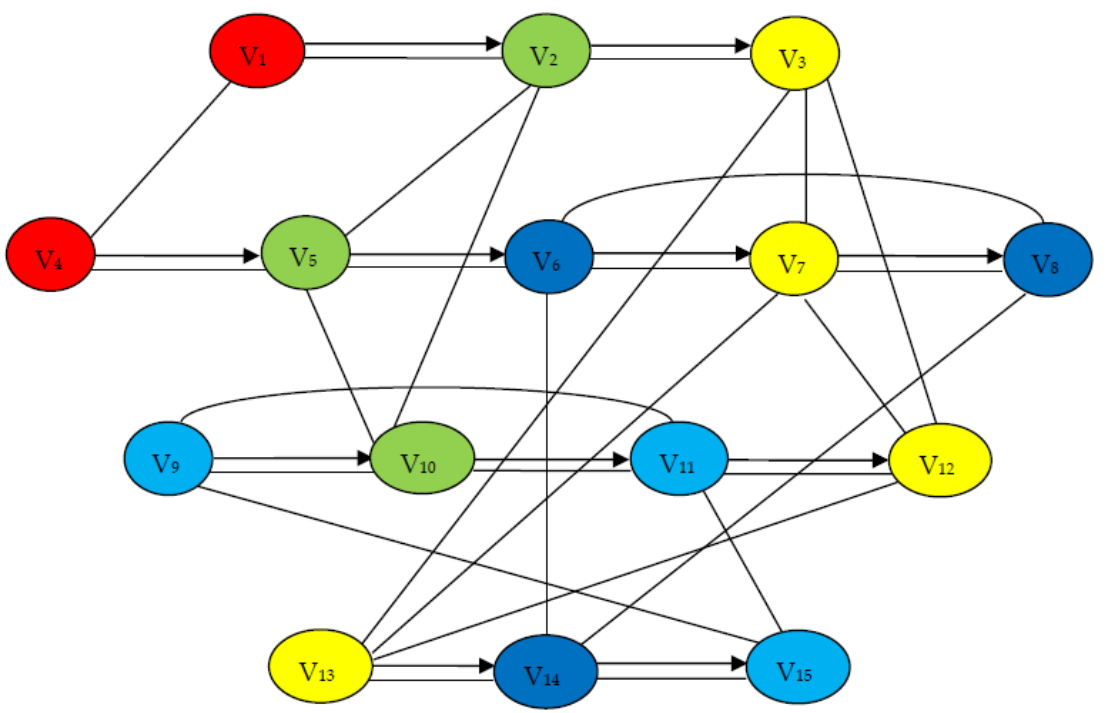
Figure 1. Mixed graph G = ( V , A , E ) determining the input date for Example 1 of the job-shop scheduling problem J | t i = 1 | C max , optimal mixed graph coloring c ( G ) being equivalent to Example